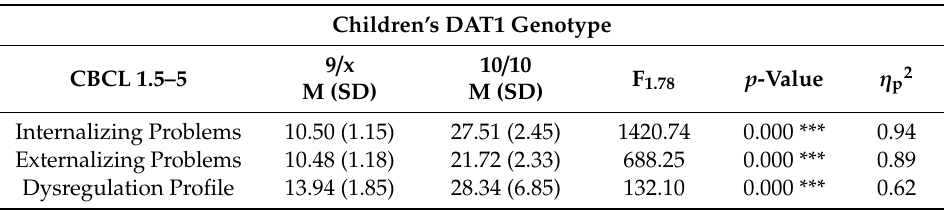
Table 3. Univariate results of the di ff erences between the two groups on children’s emotional-behavioral functioning, controlling for maternal psychopathological